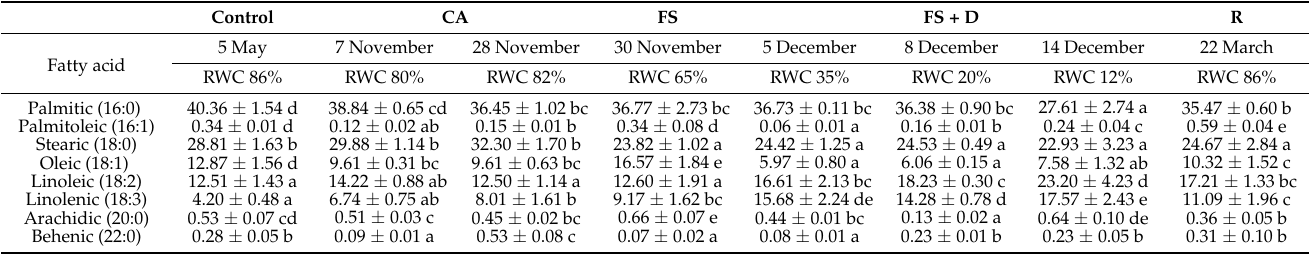
Table 1. Fatty acid composition measured in leaves of Haberlea rhodopensis collected after exposure to low temperatures during cold acclimation (CA; period: 7–28 November), after short-term exposure to freezing temperatures (FS; 30 November), after longer-term exposure to freezing temperatures when significant desiccation occurred (FS + D; period: 5–14 December) and after recovery of plants in early spring (R; period: 22 March). Data represent the mean of n = 4. The same letters within a graph indicate no significant differences assessed by Fisher’s LSD test ( p ≤ 0.05) after performing ANOVA. Percentages of RWC of leaves is reported at each time point.